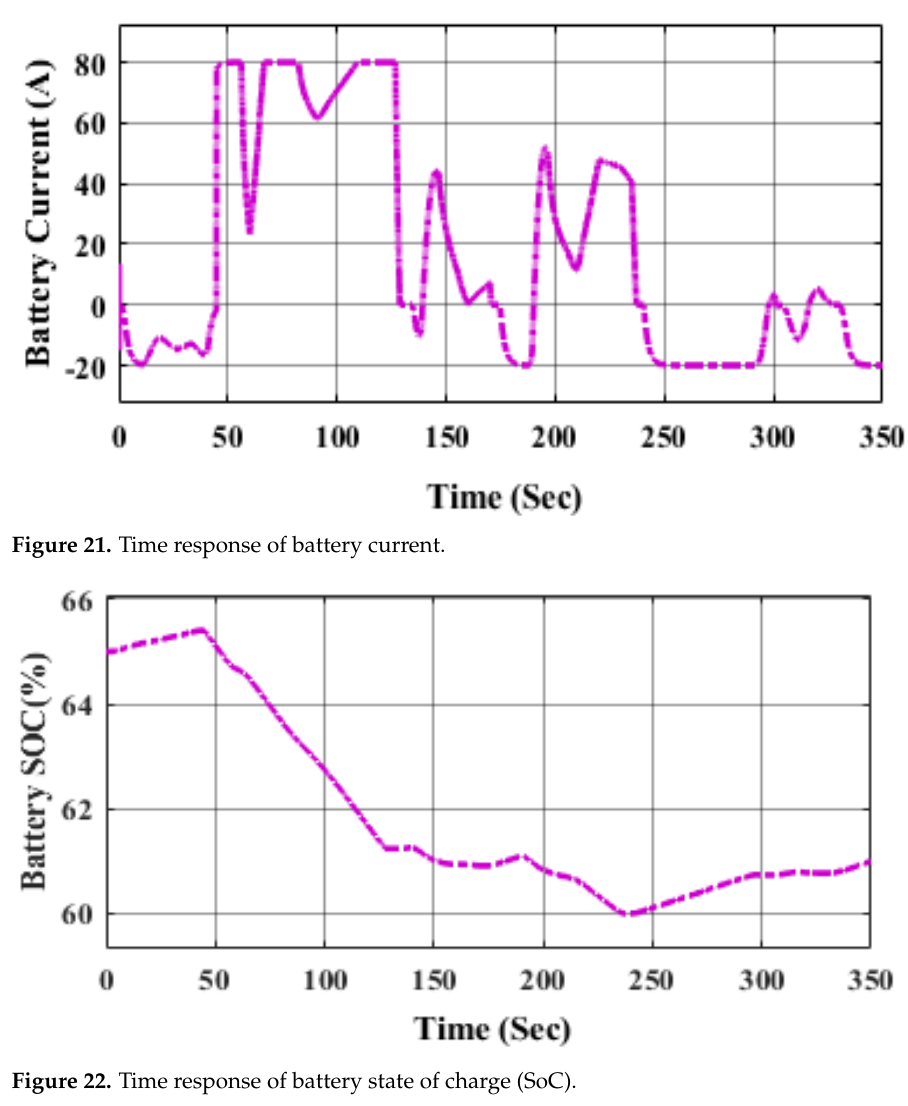
Figure 22. Time response of battery state of charge (SoC).